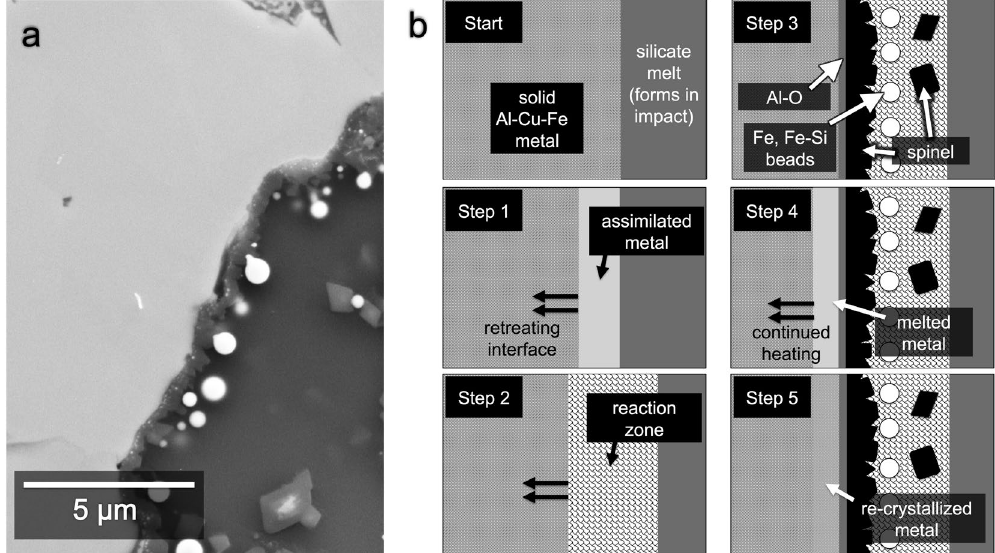
Figure 8. Redox reaction at metal-matrix interface. ( a ) BSE image showing close-up of Location f.8 (Fig. 2b). Metallic Fe beads occur mostly along interface between Al-Cu-Fe metal and glass. Spinel crust surrounds the Al-Cu-Fe metal grains. The Fe beads and spinel crust are the products of a redox reaction between Al-Cu-Fe metal and silicate melt. ( b ) Schematic illustration showing a proposed sequence of how the interaction unfolded between Al-Cu-Fe metal and silicate melt. The Start panel represents the initial contact between metal and silicate melt. In Step 1, the metal is being partially assimilated into the melt, which leads to an enrichment of Al, Cu, and Fe in the melt. The metal-matrix interface retreats into the metal. In Step 2, the interface continues to retreat, while the redox reaction occurs in the reaction zone, producing oxidized Al and metallic Fe and Si. In Step 3, the interface stops retreating and the redox reaction stops, as various phases begin to crystallize, including a layer of Al-oxide (“Al-O”), spinel crystals, and Fe and Fe-Si beads. In Step 4, the metal grains are still being heated. Some, like the one represented here, begin to melt, beginning at the metal-matrix interface. In Step 5, the system cools, and the newly melted metal regions re-crystallize. This final panel reflects what is observed in ( a